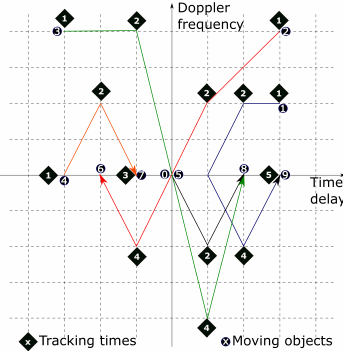
Figure 24. Multiple object tracking (MOT) allocation chart with scattering points P l , l ∈ Z L